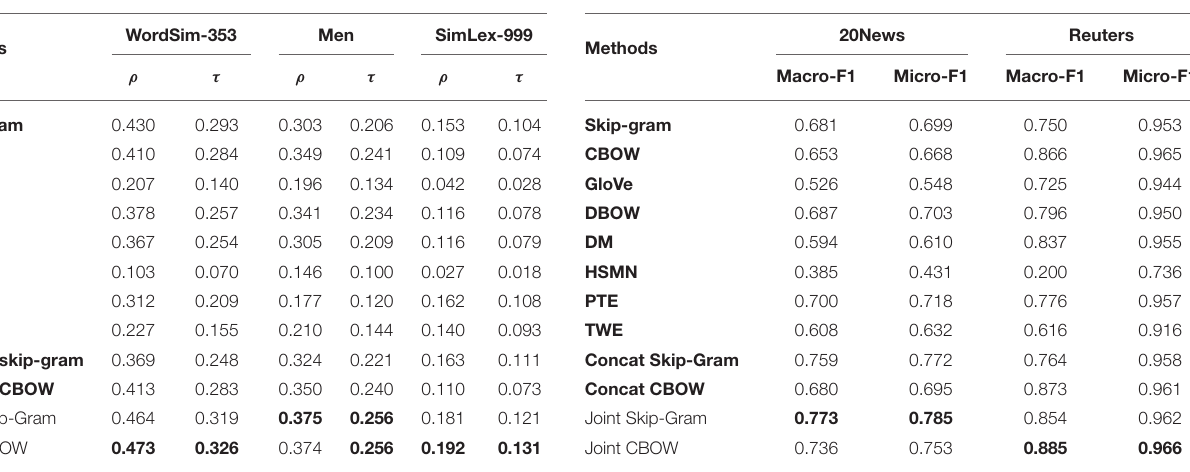
TABLE 3 | Word similarity evaluation. TABLE 4 | Text classification